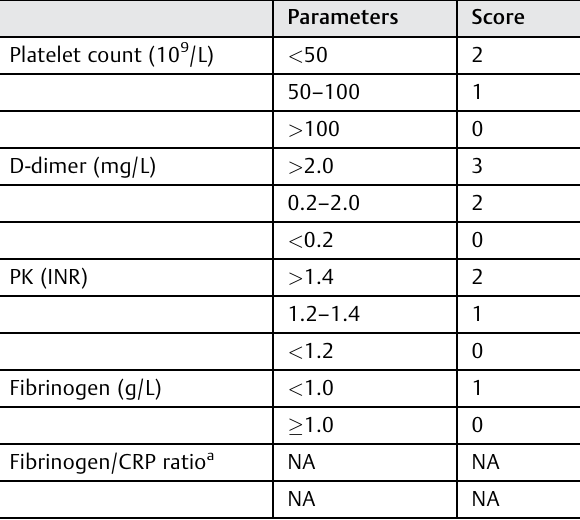
Table 1 Criteria for disseminated intravascular coagulation